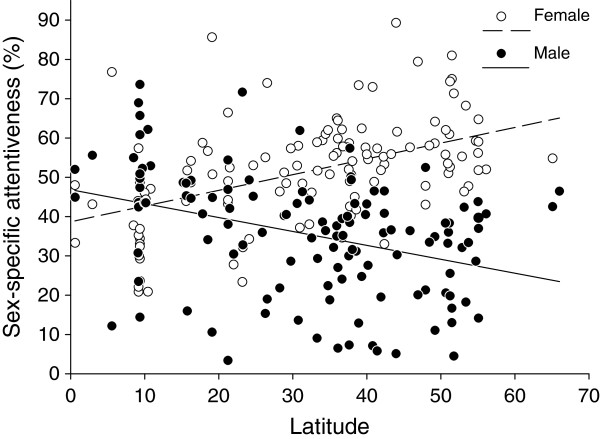
Relationship between male and female nest attentiveness and geographic latitude (degrees S or N) in species with biparental incubation (N = 124). Points are species averages and fitted lines are ordinary linear regressions for illustrative purposes only.